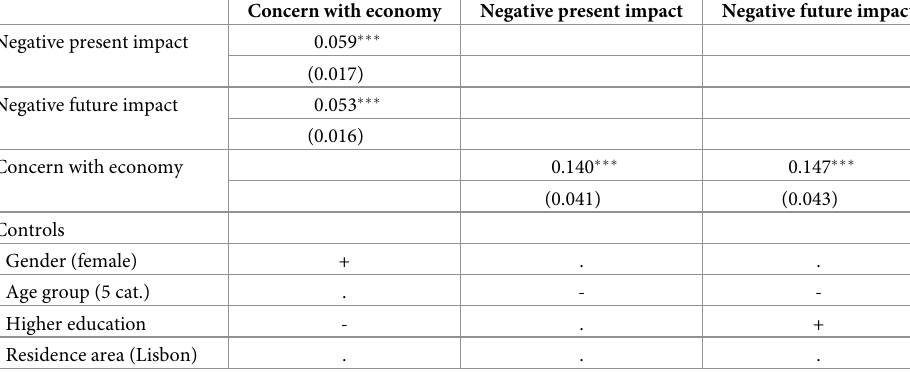
Table 8. Probit (margins) results for economic present and future impact and concern with